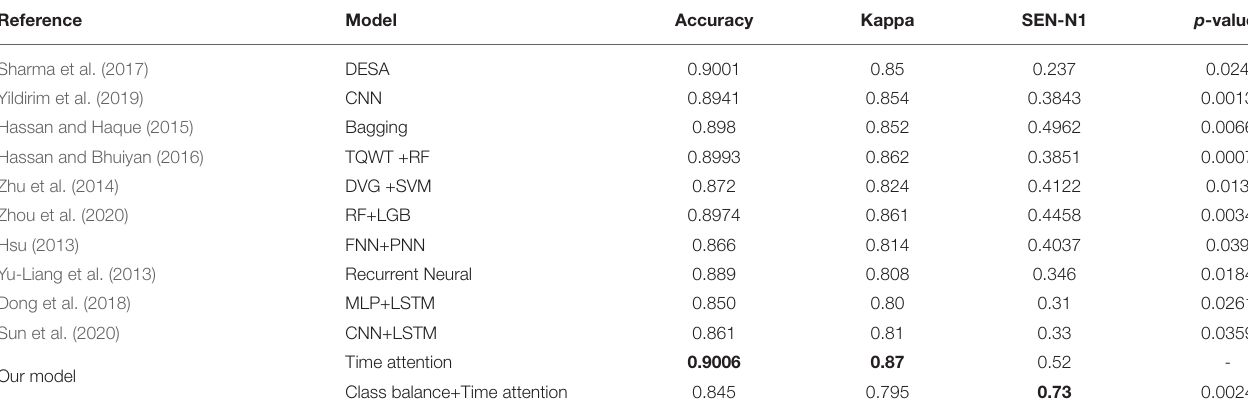
TABLE 9 | Results comparison of different methods using our own